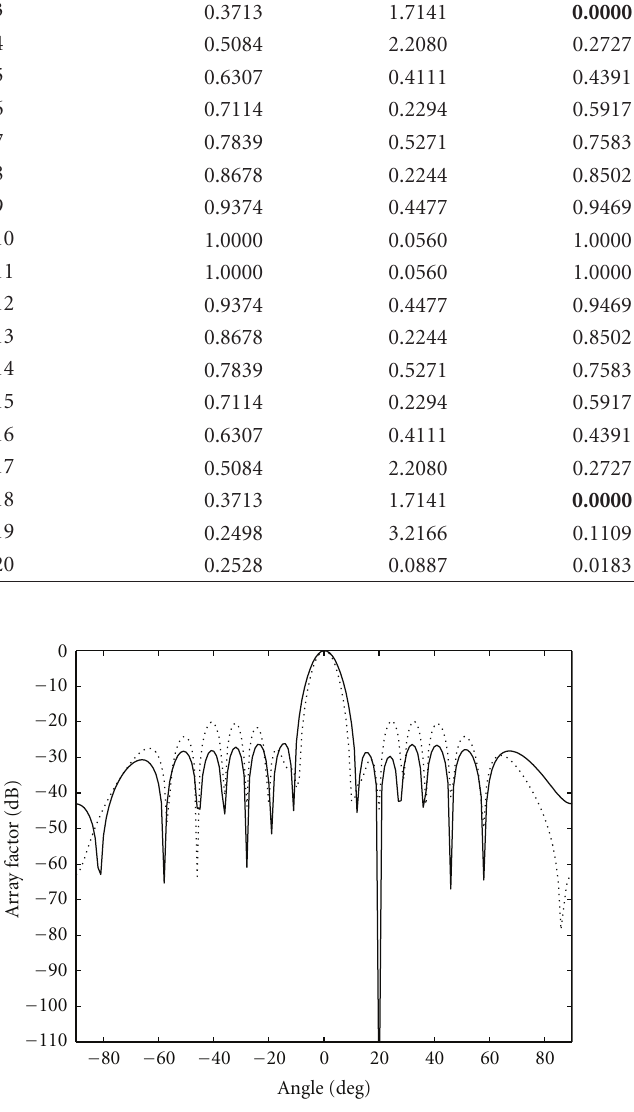
Figure 4: Convergence curve for recovery of single null in the presence of two faulty